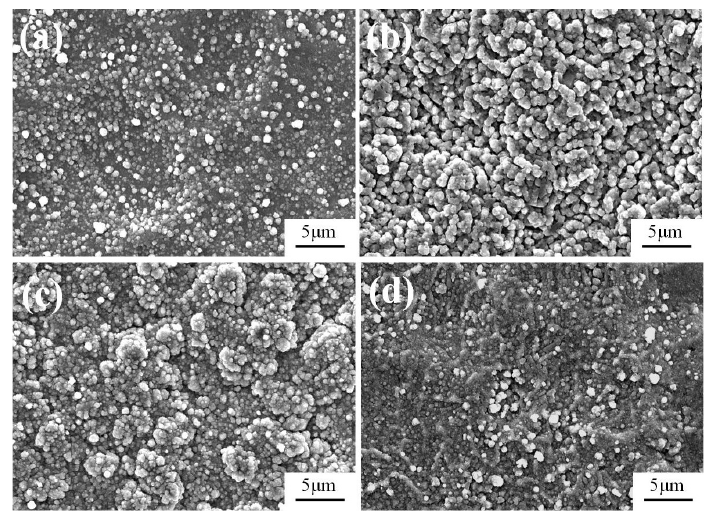
Figure 6. The surface morphology of Fe-Al-Cr alloyed layers under different electrode distances: ( a ) 10 mm; ( b ) 15 mm; ( c ) 20 mm; ( d ) 25 mm.